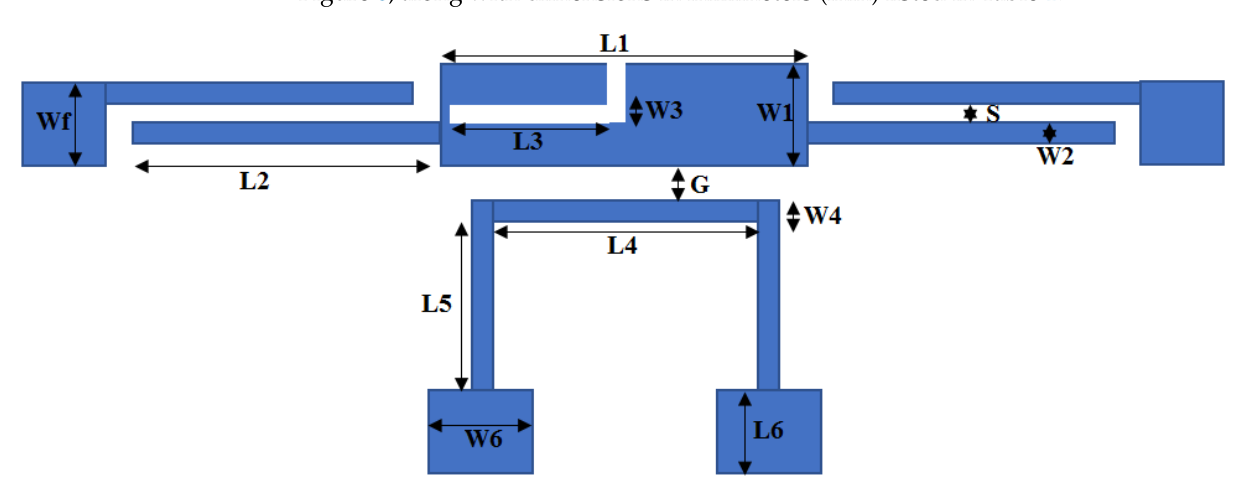
(18) Figure 5. Proposed rectangular stub configuration. 4. Proposed Dual-Notch UWB Topology In this study, two filters have been designed and fabricated (1) a UWB filter having size 0.65 λ g × 0.16 λ g , and (2) a UWB filter with dual notched bands having size 0.32 λ g × 0.08 λ g have been simulated using a 3D electromagnetic (EM) simulation software Ansys